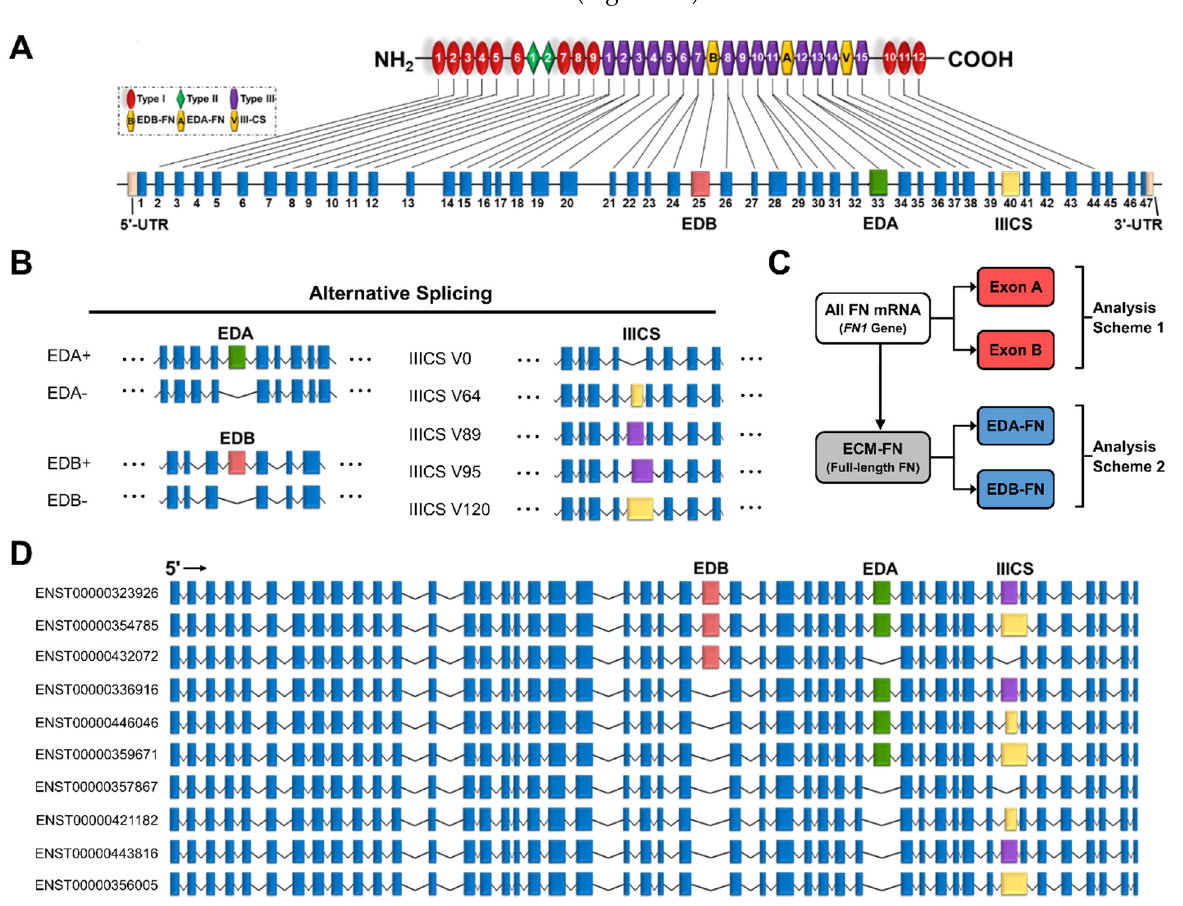
Figure 2. Transcriptome of the FN1 gene. ( A ) FN protein and exon structure. The untranslated regions and exons that exhibit alternative splicing are in colors other than blue. ( B ) Alternative splicing of the EDA, EDB, and IIICS exons. The IIICS exon exhibits five splice variants of differing amino acid length indicated in the splice variant names. ( C ) Scheme displaying how transcripts are grouped for analysis. Exon A and Exon B are compared directly with all FN mRNAs ( FN1 genes), while EDA-FNs and EDB-FNs are compared directly with ECM-FNs. ( D ) Exon structures of the 10 full-length ECM-FNs recognized in the Ensembl library.